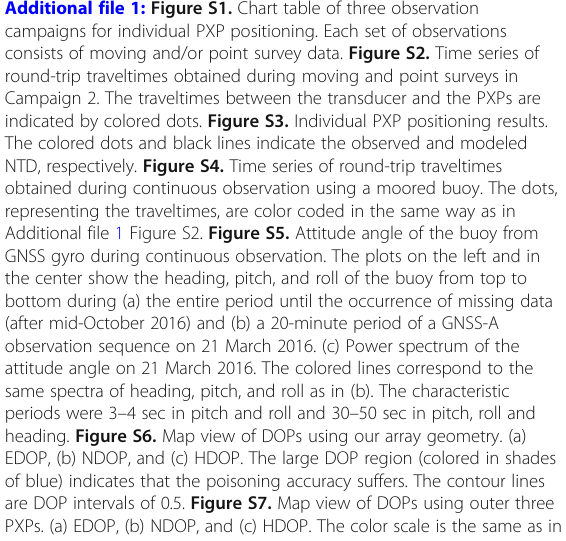
Additional file 1: Figure S1. Chart table of three observation campaigns for individual PXP positioning. Each set of observations consists of moving and/or point survey data. Figure S2. Time series of round-trip traveltimes obtained during moving and point surveys in Campaign 2. The traveltimes between the transducer and the PXPs are indicated by colored dots. Figure S3. Individual PXP positioning results. The colored dots and black lines indicate the observed and modeled NTD, respectively. Figure S4. Time series of round-trip traveltimes obtained during continuous observation using a moored buoy. The dots, representing the traveltimes, are color coded in the same way as in Additional file 1 Figure S2. Figure S5. Attitude angle of the buoy from GNSS gyro during continuous observation. The plots on the left and in the center show the heading, pitch, and roll of the buoy from top to bottom during (a) the entire period until the occurrence of missing data (after mid-October 2016) and (b) a 20-minute period of a GNSS-A observation sequence on 21 March 2016. (c) Power spectrum of the attitude angle on 21 March 2016. The colored lines correspond to the same spectra of heading, pitch, and roll as in (b). The characteristic periods were 3 – 4 sec in pitch and roll and 30 – 50 sec in pitch, roll and heading. Figure S6. Map view of DOPs using our array geometry. (a) EDOP, (b) NDOP, and (c) HDOP. The large DOP region (colored in shades of blue) indicates that the poisoning accuracy suffers. The contour lines are DOP intervals of 0.5. Figure S7. Map view of DOPs using outer three PXPs. (a) EDOP, (b) NDOP, and (c) HDOP. The color scale is the same as in